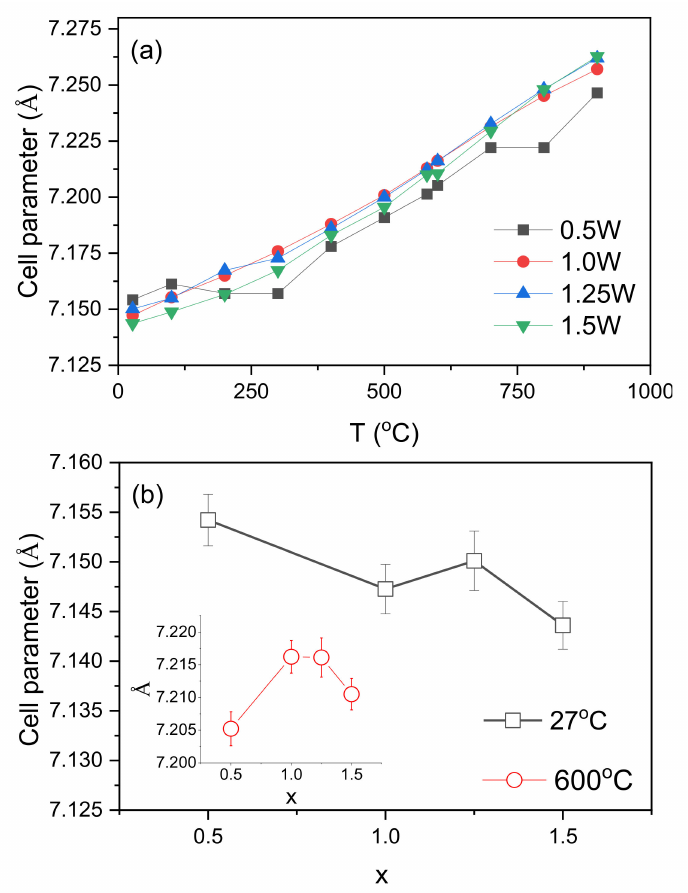
Figure 2. ( a ) Variation of unit-cell parameters at different temperatures for different W-substituted samples. ( b ) Composition dependence of unit-cell parameters at two temperatures. The solid lines are guides to the